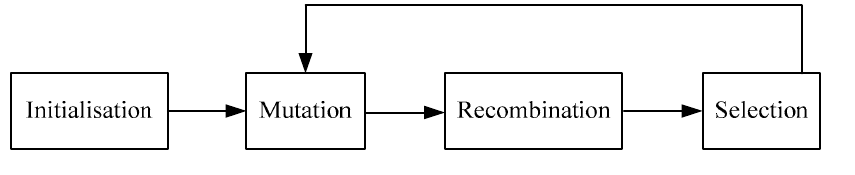
Figure 4. Block diagram of DE algorithm.